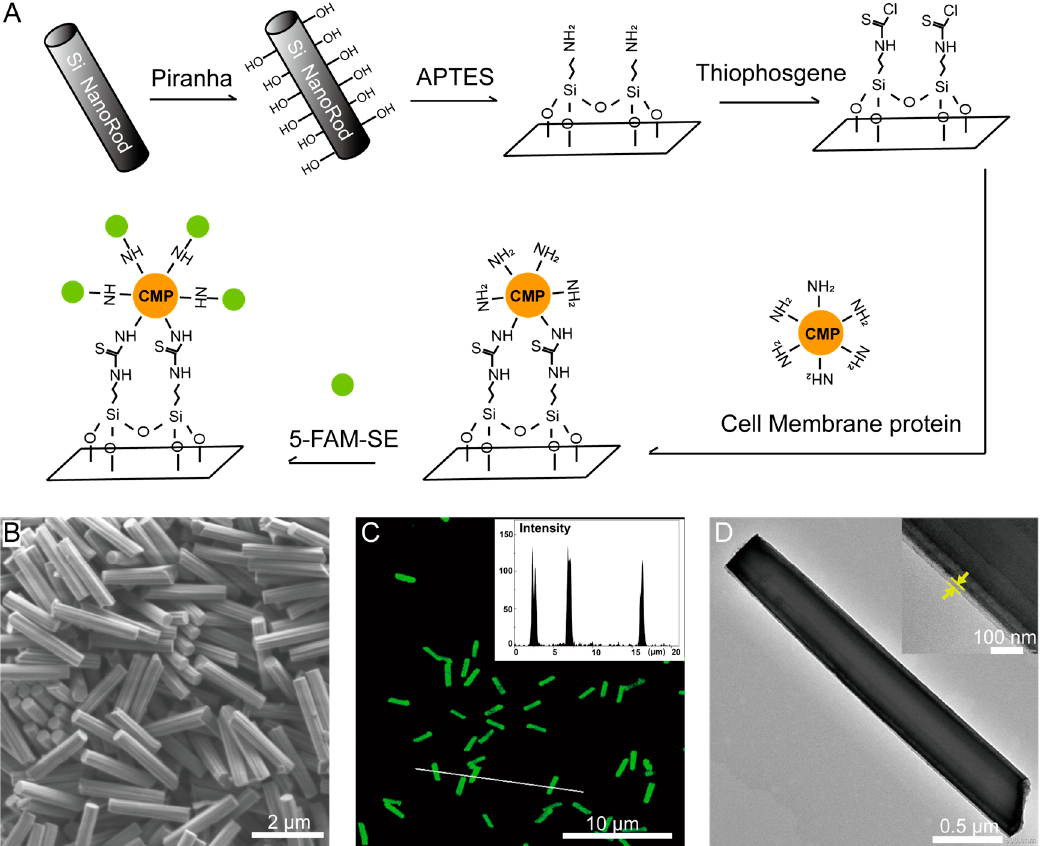
Figure 2. Coating and characterization of silicon nanorods: ( A ) Scheme of SiNR fabrication, ( B ) SEM images of the SiNR, ( C ) Silicon nanorods labeled with fluorescence (SiNR-CMP-FAM), and ( D ) transmission electron microscope image of a single SiNR with CMP (from Hela cell). Scale bar indicates 500 nm. Detailed TEM image of CMP (inner picture), yellow arrow indicates CMP layer. Scale bar stands for 100 nm.